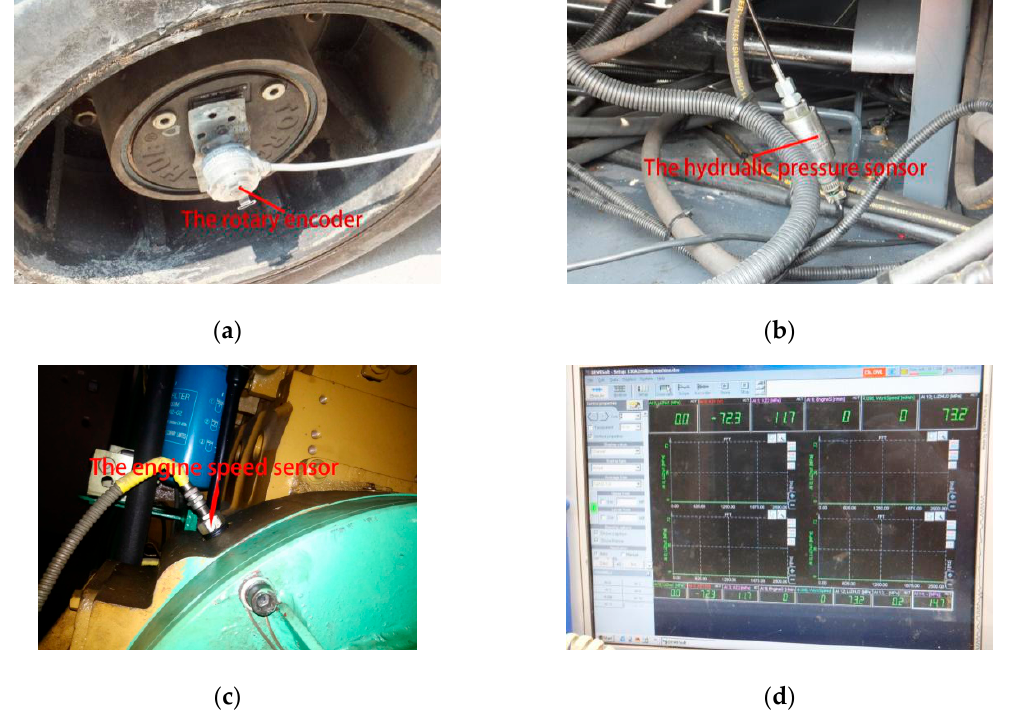
Figure 9. The sensors and data acquisition instrument: ( a ) the work speed sensor; ( b ) the drive hydraulic pump pressure sensor; ( c ) the engine speed sensor; ( d ) the data acquisition instrument.